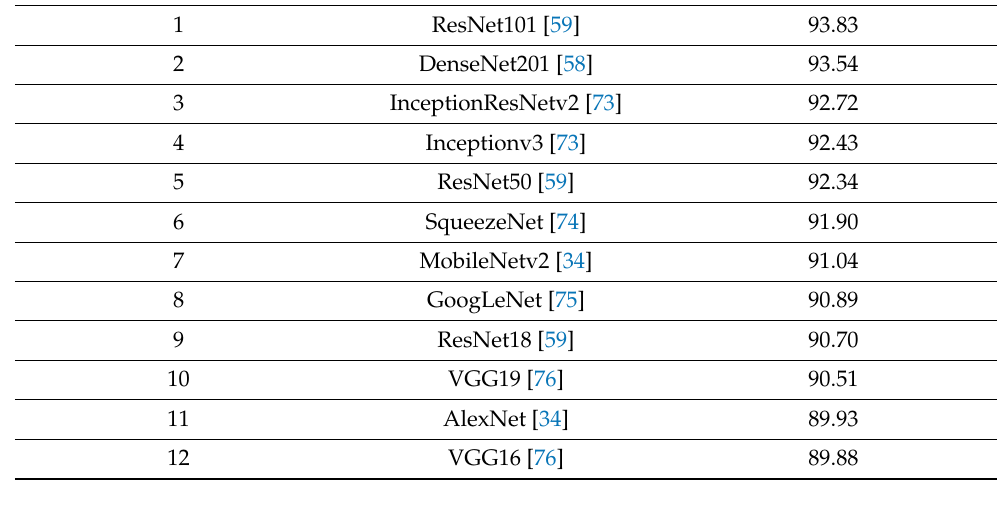
Table 4. Accuracy results obtained using various transfer learning models with our face mask image dataset. These results were obtained for Case 1.